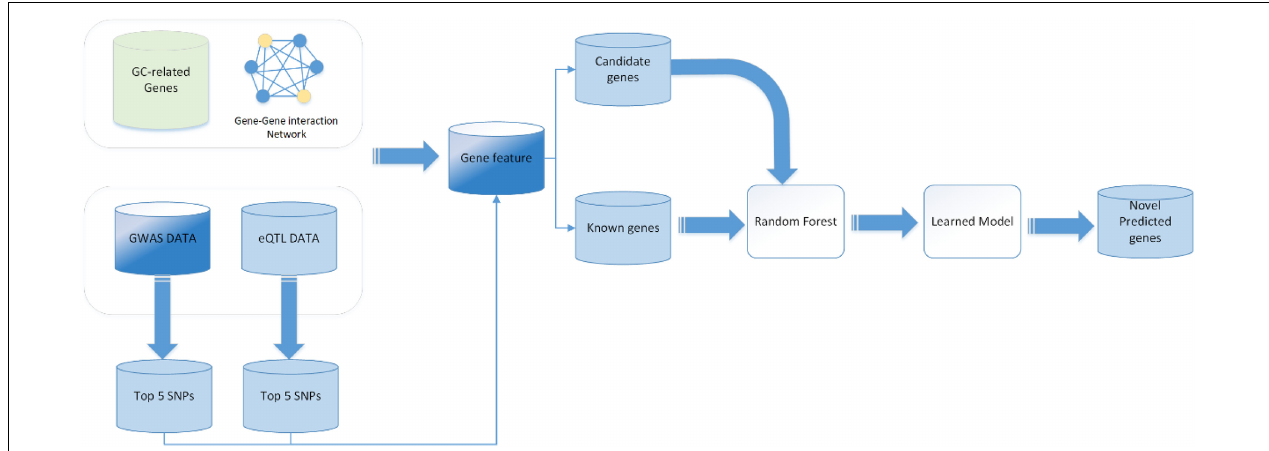
FIGURE 1 | Workflow of gastric cancer-related genes